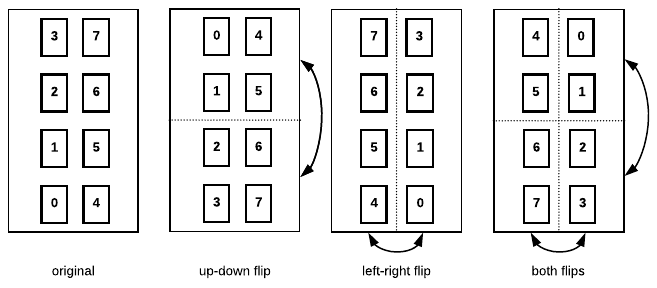
Figure 6. Flipping of the sensor data, which corresponds to rotating the user on the mat.